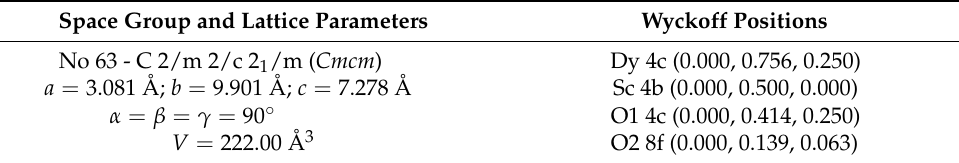
Figure 14. Calculated phonon dispersion curves of the Cmcm phase at 15 GPa. Table 7. Crystallographic description of Cmcm at 15